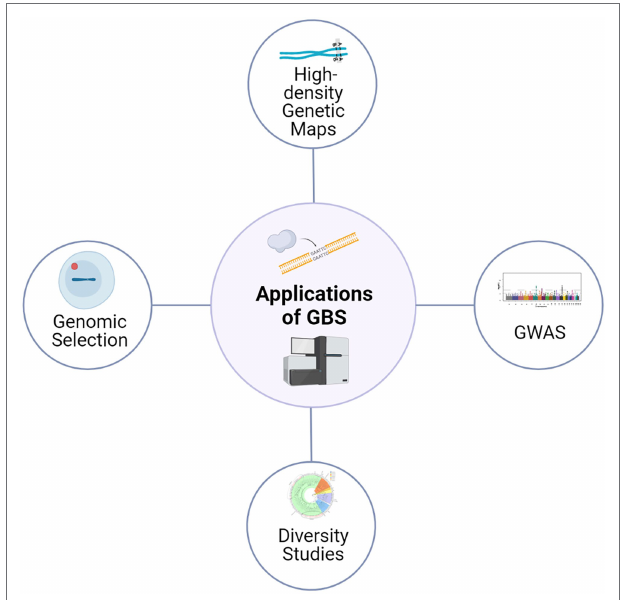
FIGURE 1 | Application of GBS approaches for various genetics and plant breeding studies. The high-quality SNPs derived from GBS are being used for diversity analysis, genetic map construction, genome-wide association studies and genomic